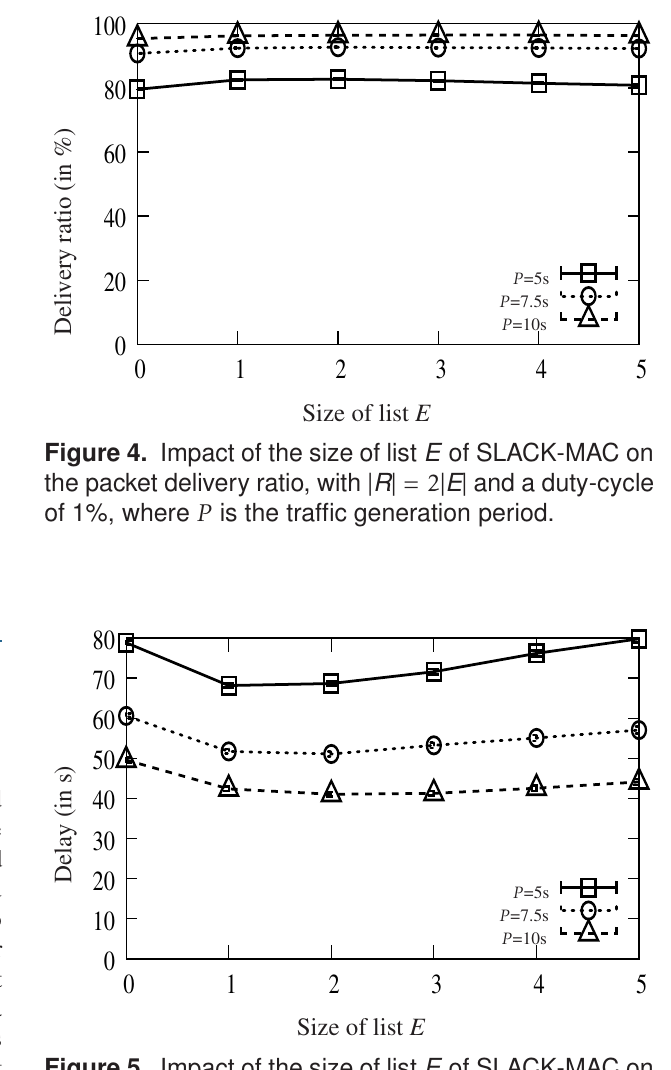
Figure 5. Impact of the size of list E of SLACK-MAC on the end-to-end delay, with | R | = 2 | E | and a duty-cycle of 1%, where P is the traffic generation